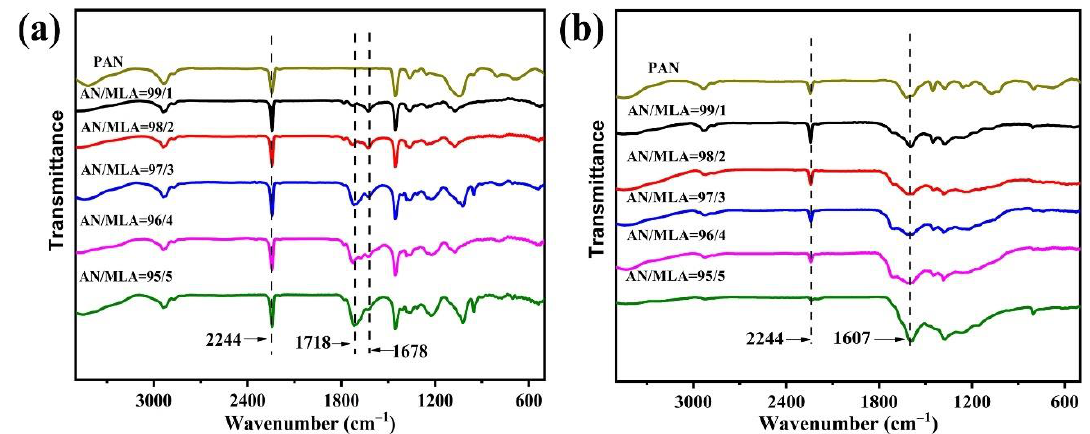
Figure 5. FTIR spectra of P (AN- co -MLA) copolymers with different feed ratios and PAN homopolymer: ( a ) original and ( b ) stabilized 200 °C for 30 min.